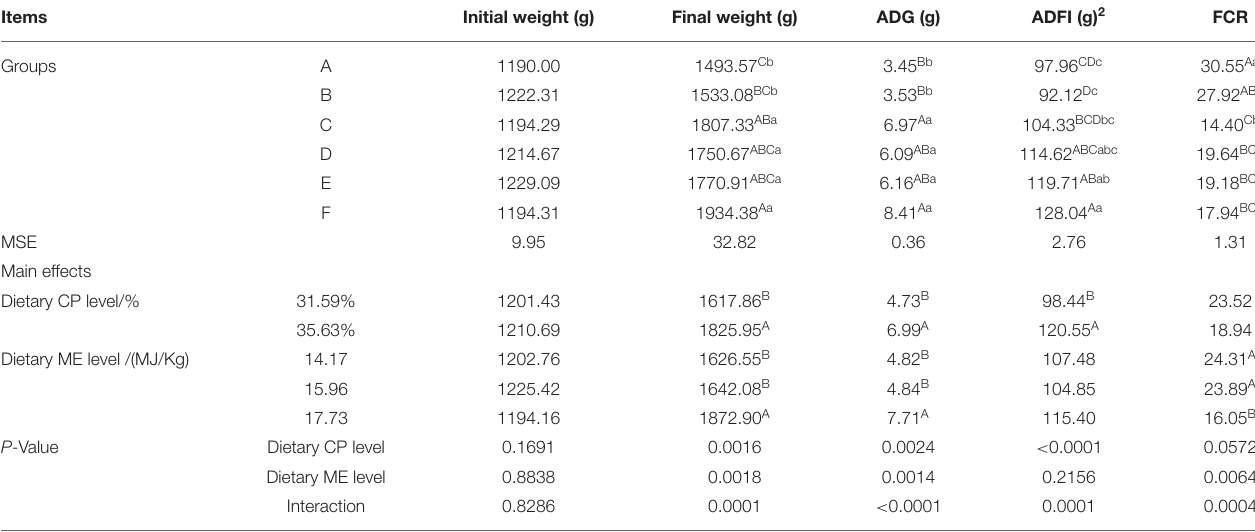
TABLE 3 | Effects of energy and protein levels on growth performance of mink during growing period 1 .